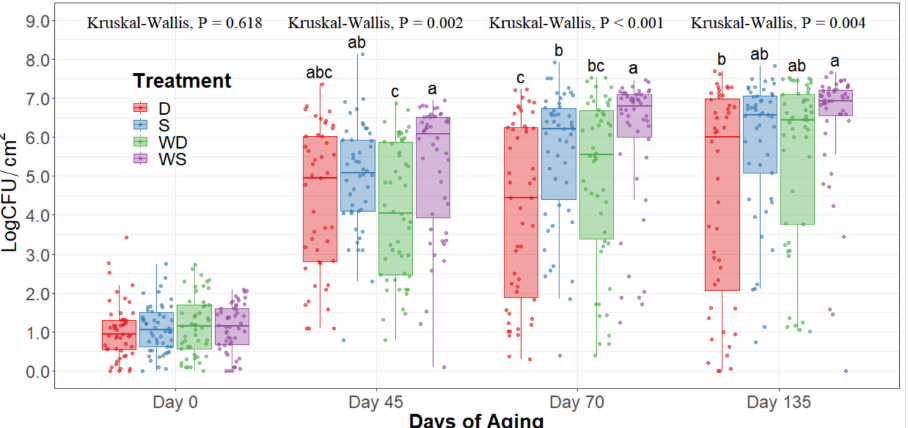
Figure 4. Psychrotroph counts of striploins at day 0, 45, 70, and 135 of refrigerated storage. The horizontal line within the box plot represents the median. The box upper and lower limits represent the interquartile range, and the bars represent the 1.5xInterquartile Range. D = No Wash Dry chill, S = No Wash Spray chill, WD = Wash Dry chill, WS = Wash Spray chill. a–c Box plots with different letters within each sampling date are significantly different ( p < 0.05).